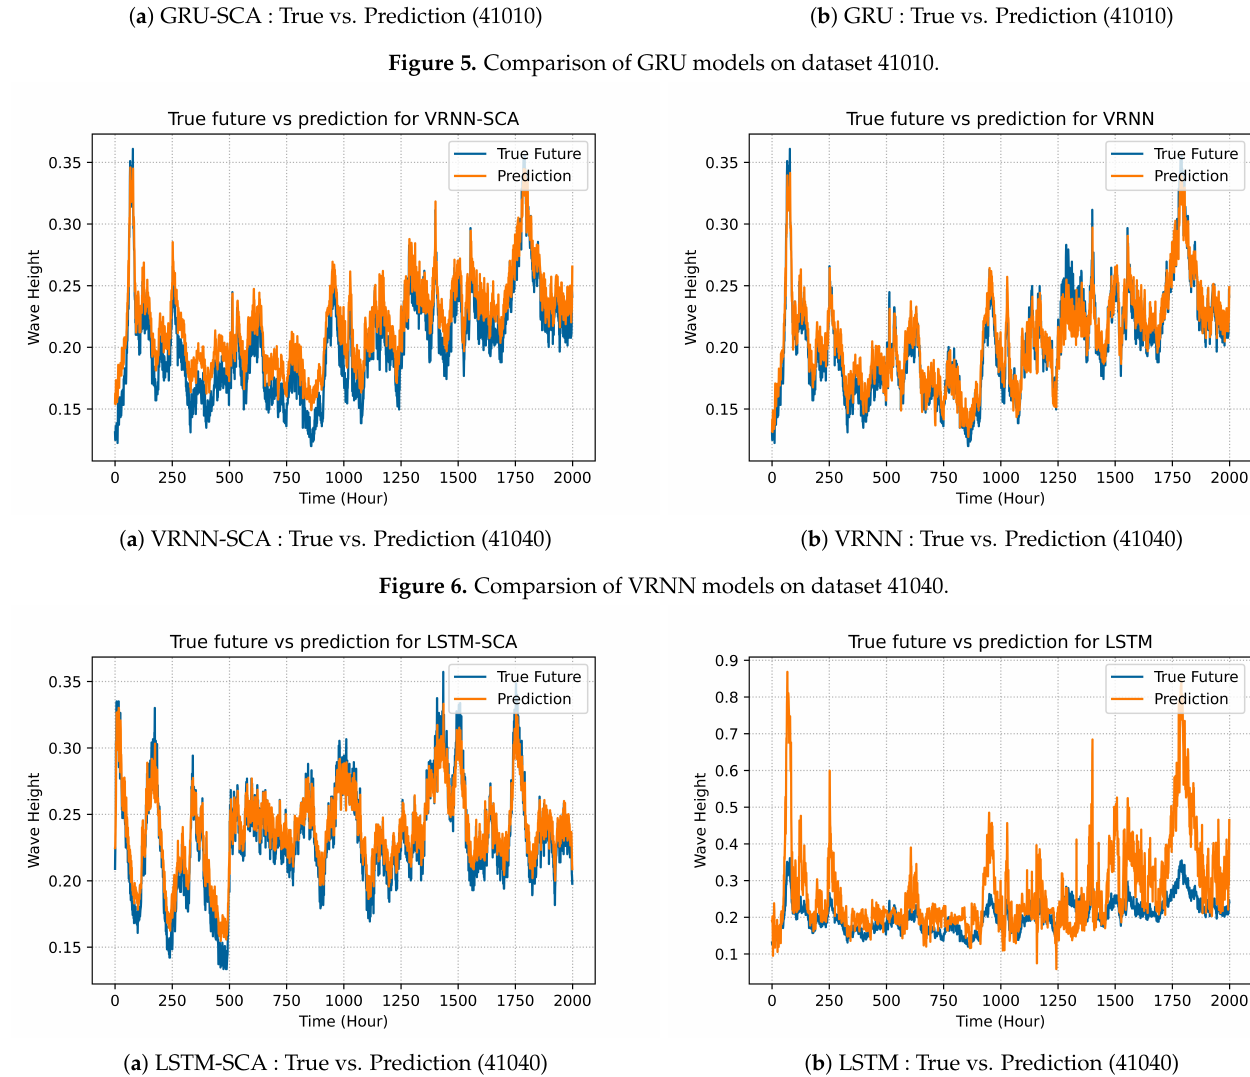
Figure 7. Comparison of LSTM models on dataset